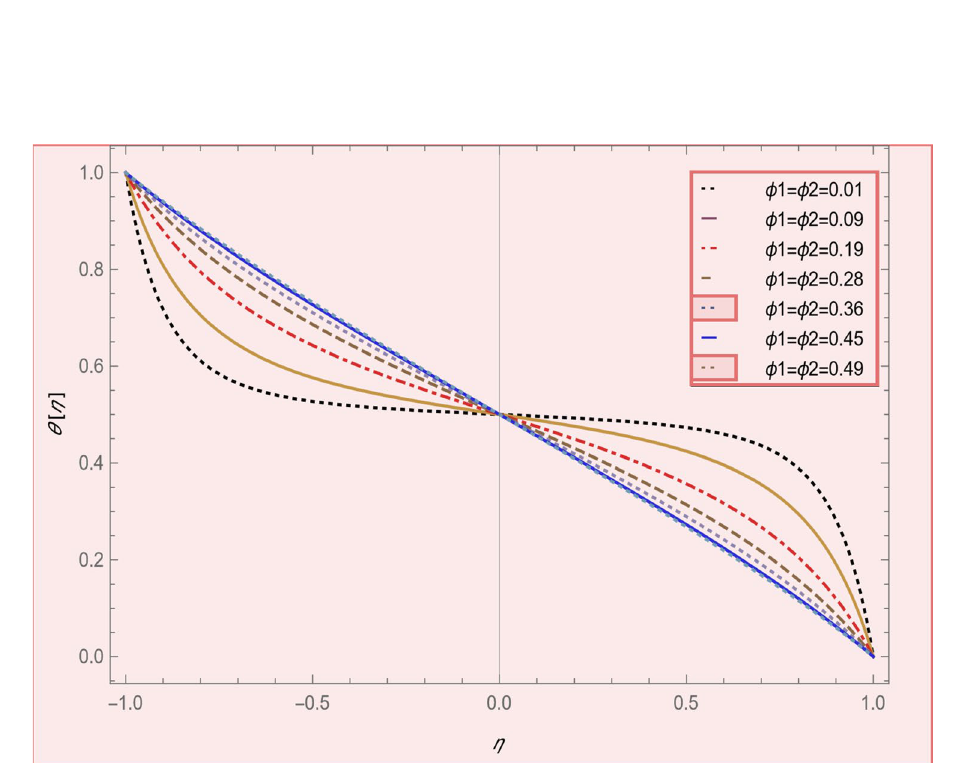
Figure 5. Temperature profile effect in volume fraction for α = − 4, R = − 1, M = 1, SC = 1, Pr = 6.2